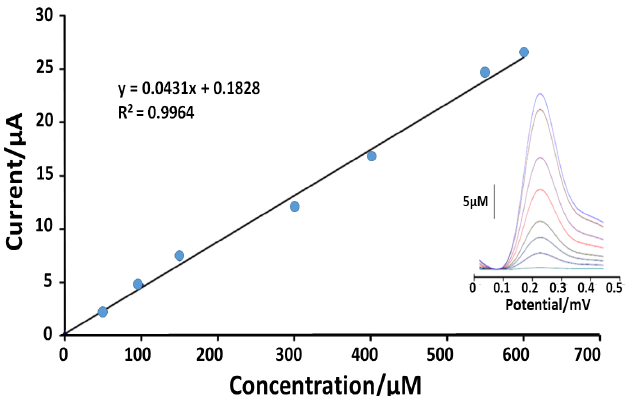
Figure 4. Current-concentration curve for the oxidation of FA in the range of 3.0 nM–250 µ M. Inset: relative DP voltammograms of FA at surface of PE/CuO-CNTs/BDHFP [52].